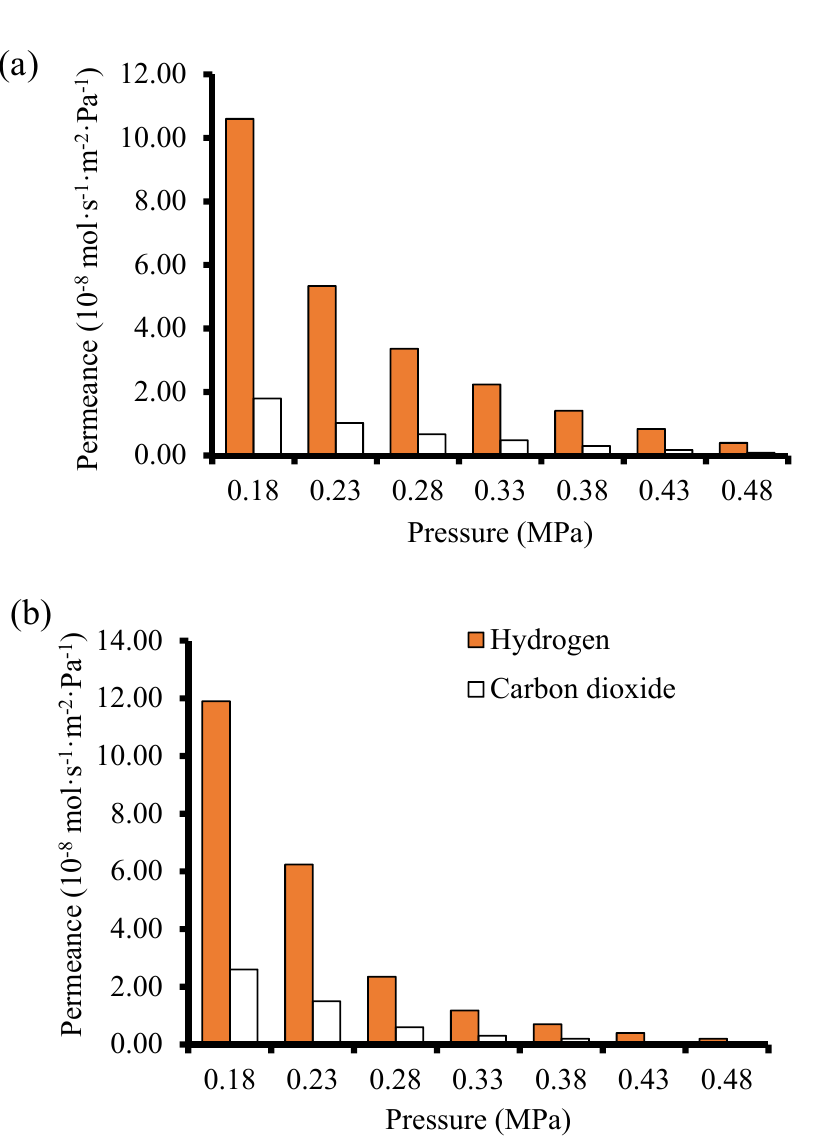
Figure 12. Gas permeance as a function of pressure during the mixture gas separation at 25 °C ( a ) membrane M4 prepared using 2-interruption steps PPH synthesis method ( b ) Membrane B1 prepared by the direct hydrothermal synthesis method.